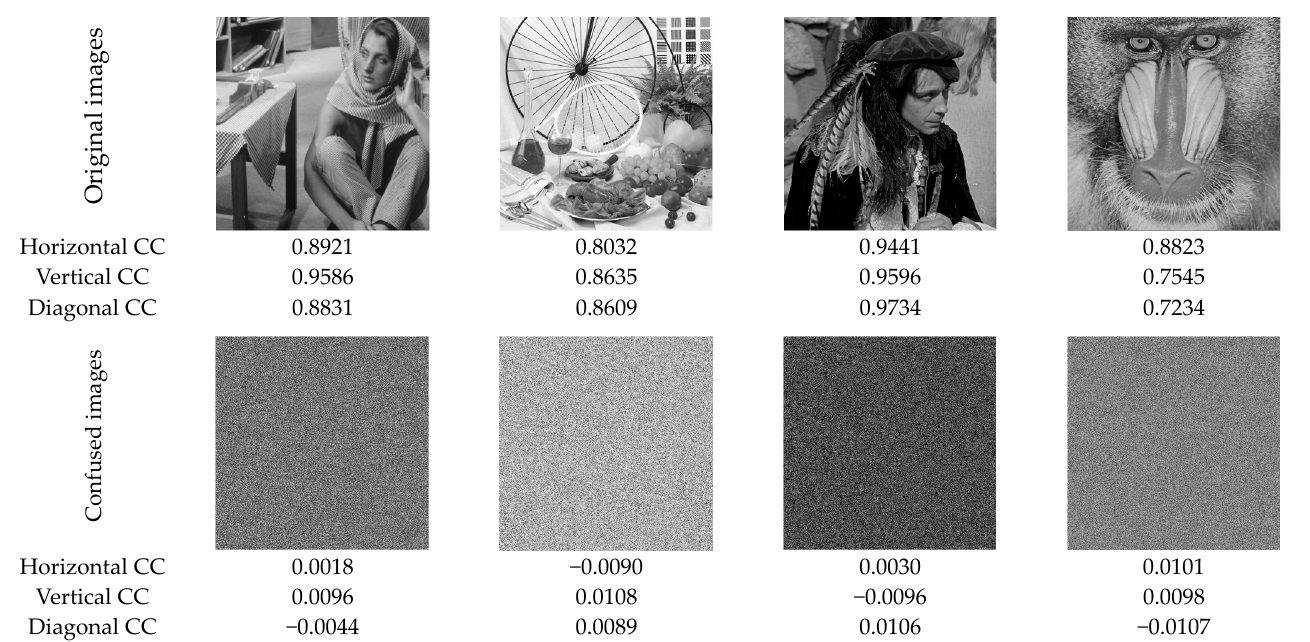
512 512 × and their confused versions with the corresponding